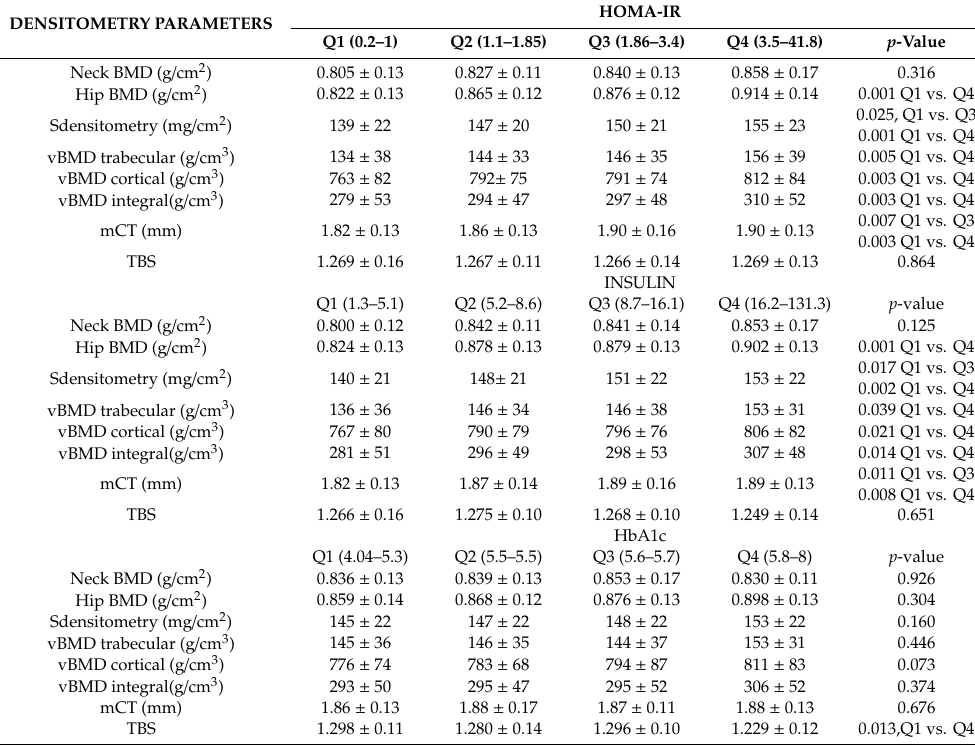
Table 3. Densitometry parameters according quartiles of HOMA-IR, insulin, and HbA1c. DENSITOMETRY